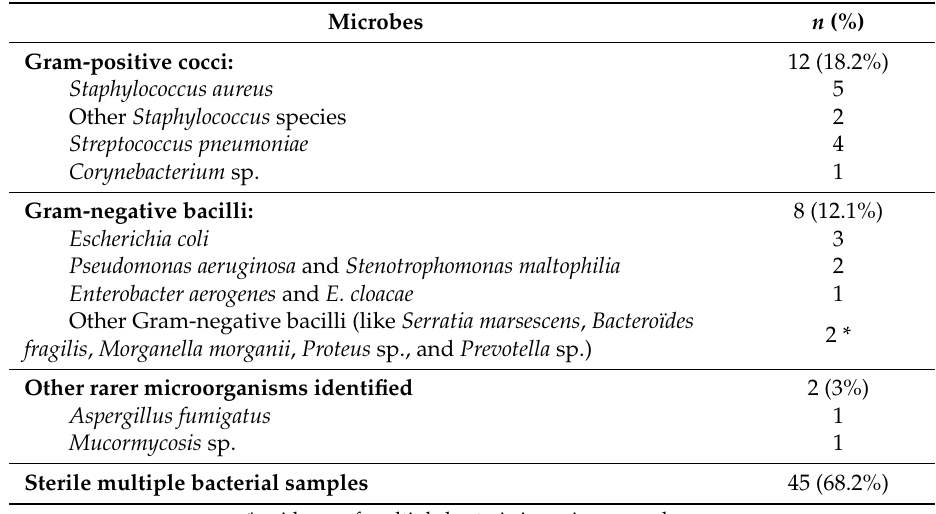
Table 4. Microbial infections documented in 21 patients (data available for 66